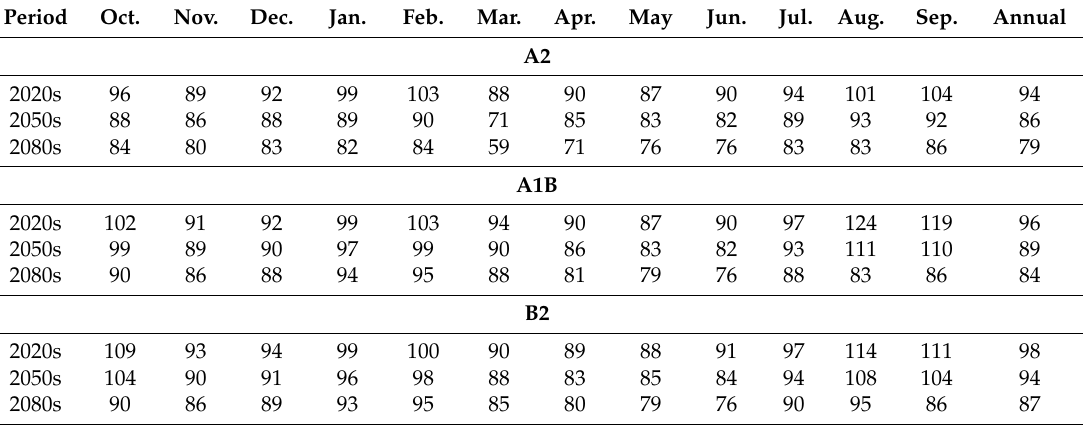
Figure 9. Average annual flow regimes in Zambezi River at Victoria Falls gauging station for the reference period 1961–1990 and for projected future periods for different emission scenarios. The y axis is flow in m 3 /s. Table 7. Monthly flow changes in Zambezi River at Victoria Falls. All figures in % of flow in the reference period 1961–1990. Emission scenarios A2, A1B and